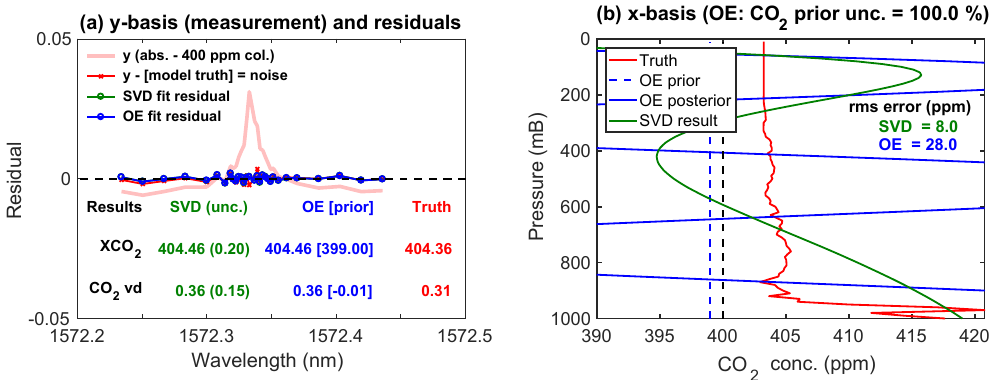
Figure 6. Sample retrieval for a single simulated measurement (noise instance) under a weak constraint (four principal components for SVD, 100% prior uncertainty for each CO 2 level for OE). (a) The SVD and traditional OE approaches successfully minimize the fit residual to match that of the noise, thus demonstrating convergence. Results projected to the z basis show reasonable performance of the X CO mean (first principal component) but poor performances for higher-order terms (not shown), indicating overfitting to the noise. (b) Results projected to the x basis show highly oscillatory and divergent profiles due to the instability in overfitting. Thus, traditional OE results in the full model x basis are not useful and need projection onto the z basis or other transformation. Note that this has been shown for illustrative purposes. A proper evaluation of the methods requires an ensemble average of such simulations (see Fig. 8 left and